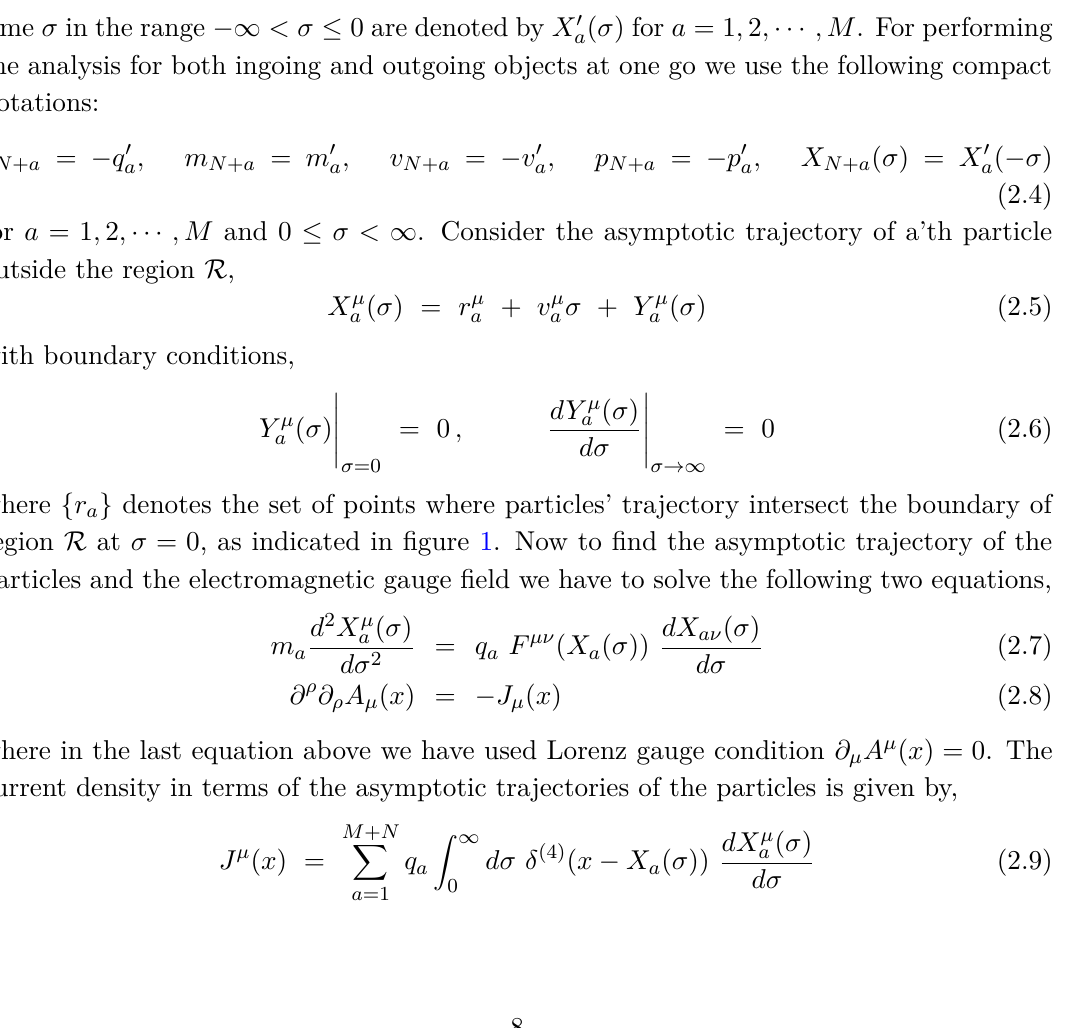
Figure 1 . A scattering process describing M number of particles are coming into region R , going through unspecified interaction inside the region R and disperse to N number of particles. Outside the region R only long range electromagnetic and/or gravitational interaction is